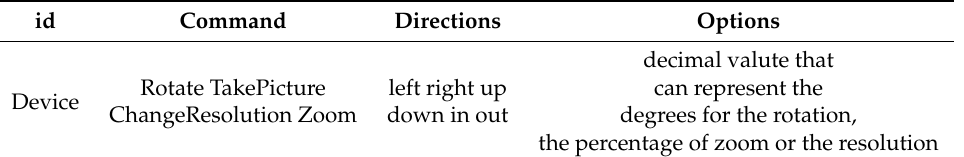
Table 3. Commands that can be received by a camera